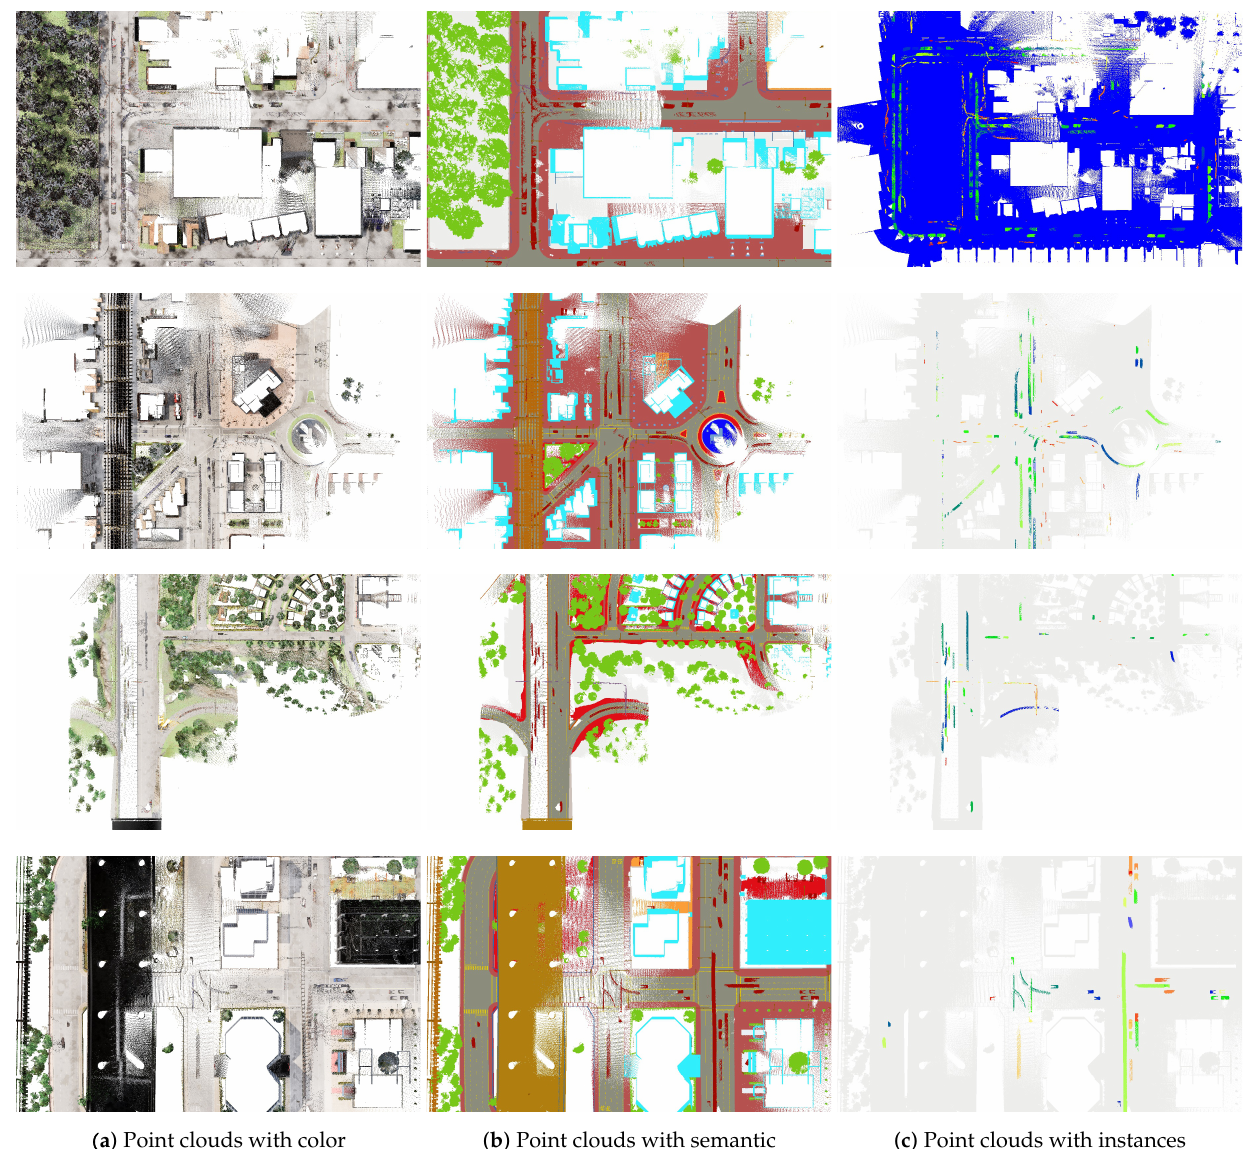
Figure A4. CARLA Training set . From top to bottom: T 2 , T 3 , T 4 , T 5 (synthetic data).